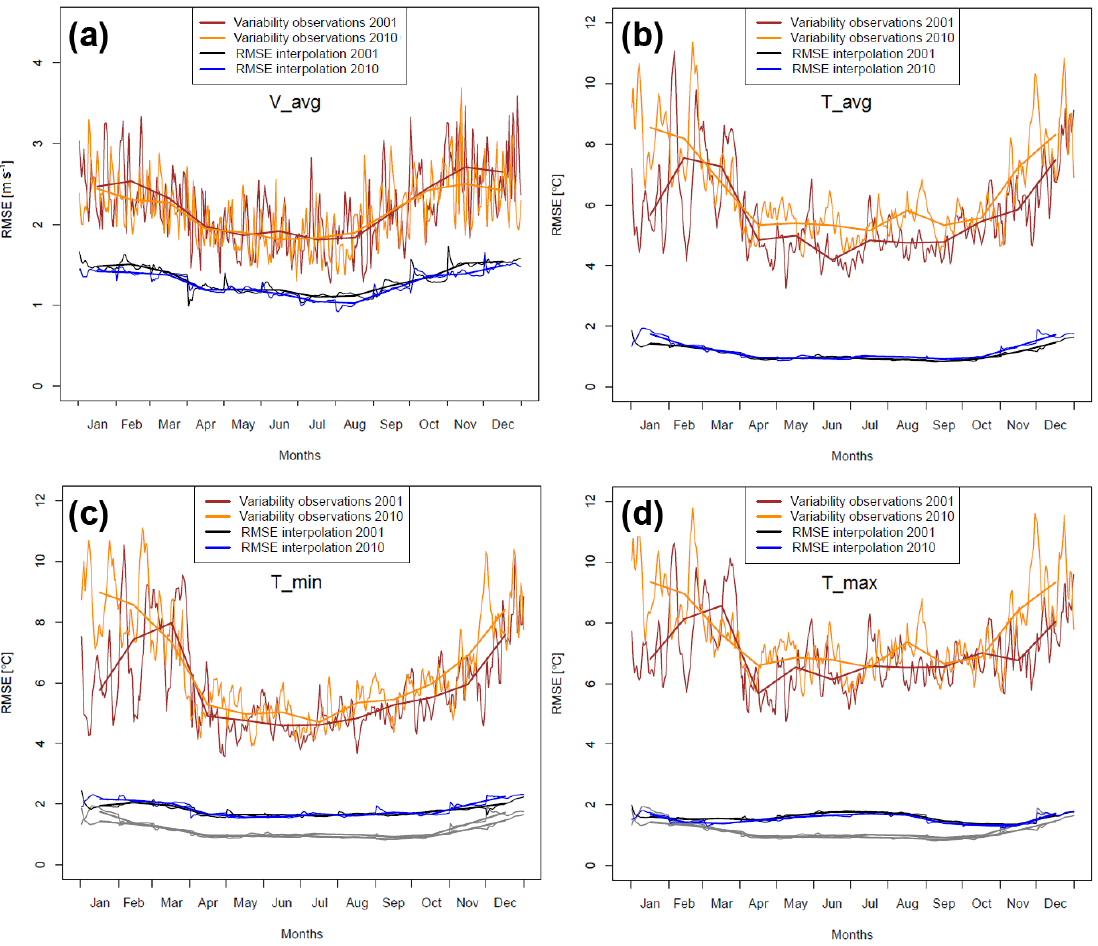
Figure 18. Annual cycle of daily RMSE according to cross validation for 2001 (black) and 2010 (blue) for (a) mean wind speed V avg , (b) mean temperature T avg , (c) minimum temperature T min and (d) maximum temperature T max . For comparison, the daily standard deviation over all station observations is displayed in brown (2001) and orange color (2010). Corresponding curves of monthly means are added to all data. In panels (c) and (d) the RMSE data for T avg are displayed in grey color for